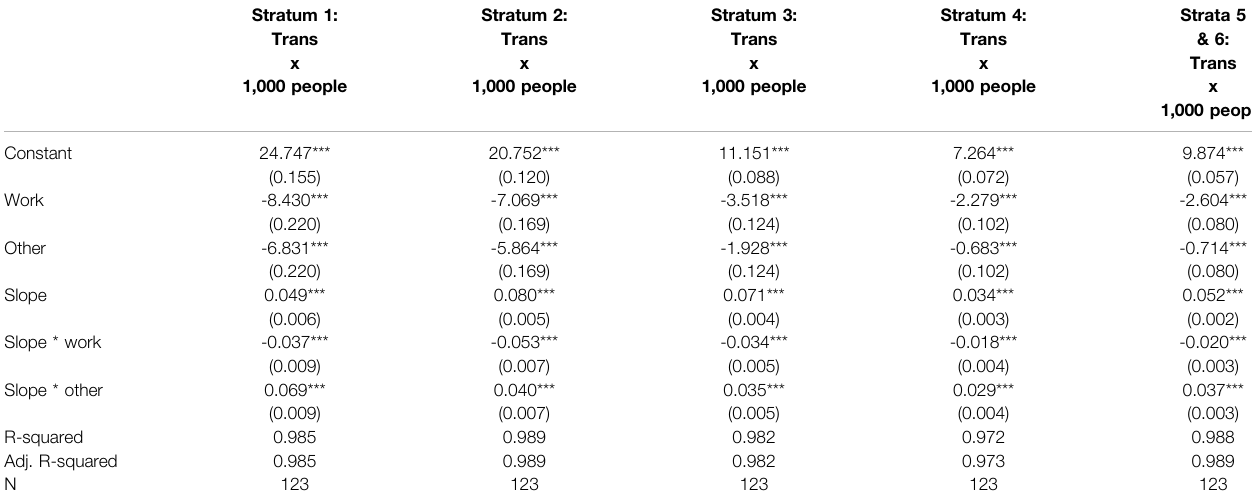
TABLE 4 | OLS estimation. Dependent variable is the transactions per 1,000 population. For the categorical variable activity origin type, category home is the base. Estimation period: Sep/01 to Oct/12 (41 days), excluding weekends.